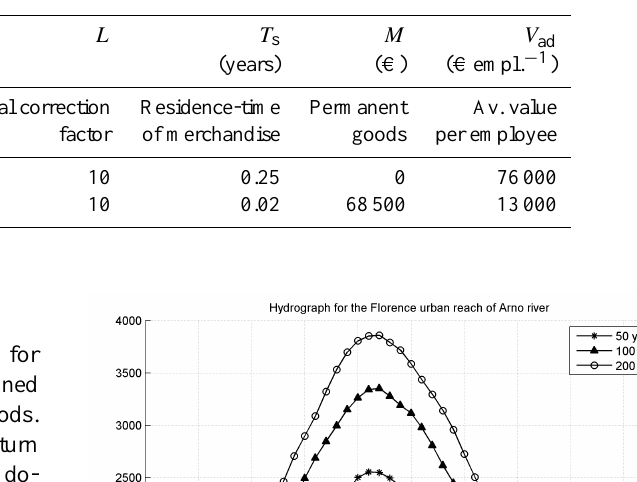
Table 2. Summary of the parameters used for the evaluation of the average value per employee for the commercial sector described in Sect. 3.4.